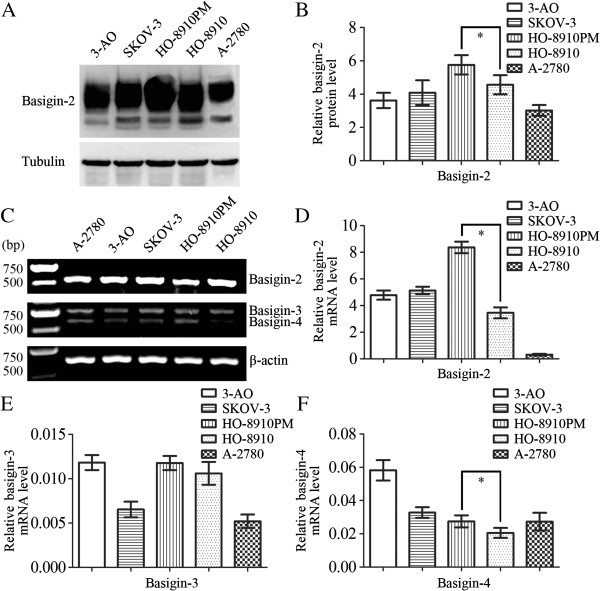
Expression levels of basigin-2, basigin-3 and basigin-4 in ovarian cancer cells. A-B Western blot analysis determining the relative protein expression levels of basigin-2 in ovarian cancer cells. Basigin-2 protein expression levels were quantified using Quantity One normalized against tubulin levels. C RT-PCR analysis of basigin-2, basigin-3 and basigin-4 mRNA expression levels in ovarian cancer cells. D-F Real-time PCR analysis determining the relative mRNA expression levels of basigin-2, basigin-3 and basigin-4 in ovarian cancer cells. Columns mean derived from at least three independent experiments, bars, SD. Statistical analysis was done using Student’s t tests. *P < 0.05, significant.